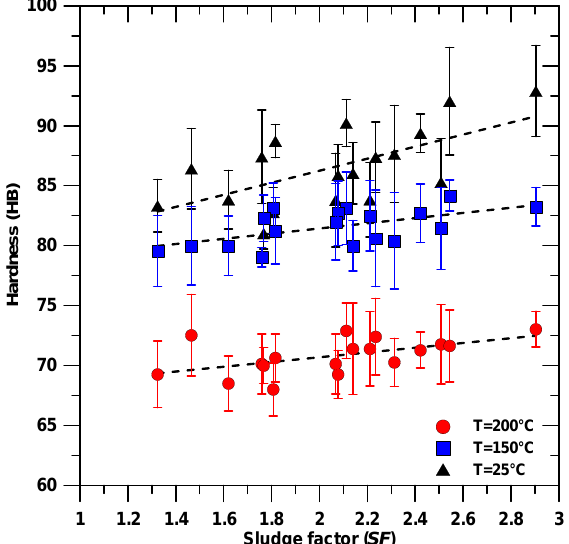
Figure 9. Brinell hardness tendency as a function of the sludge factor, SF, in the diecast experimental AlSi9Cu3(Fe) alloys.